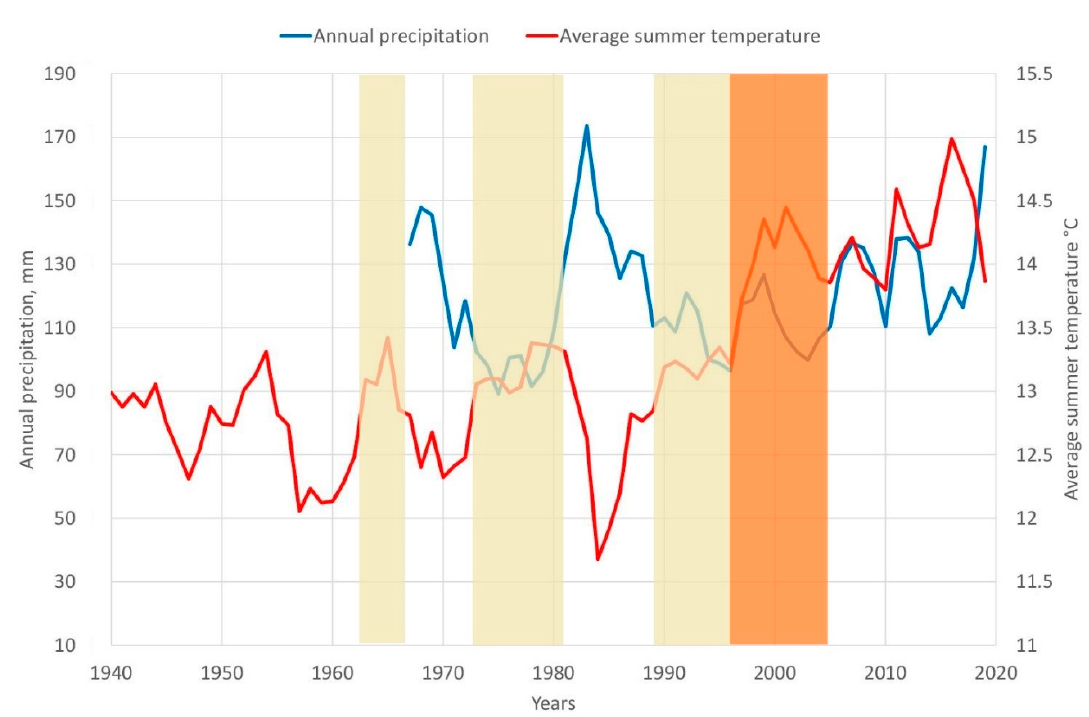
Figure 11. Annual precipitation (mm) and average summer temperature (°C), Kosh-Agach meteor- ological station (1758 m a.s.l.). The periods, unfavorable for the glaciers are marked with yellow bars and orange bar (extremely unfavorable).